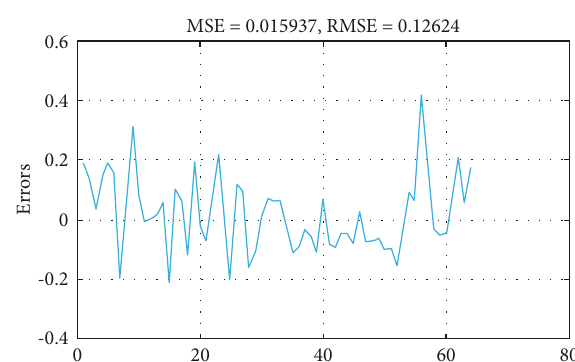
Figure 9: MSE and RMSE for test data